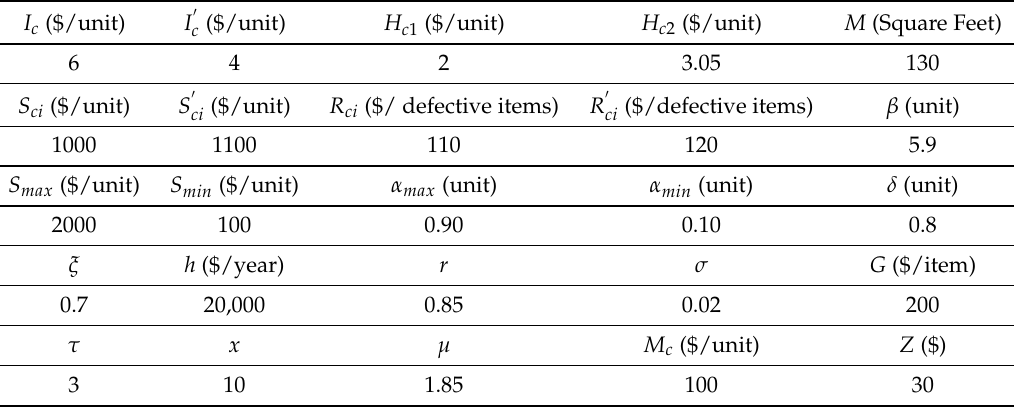
Table 2. Input parameters of Example 1.